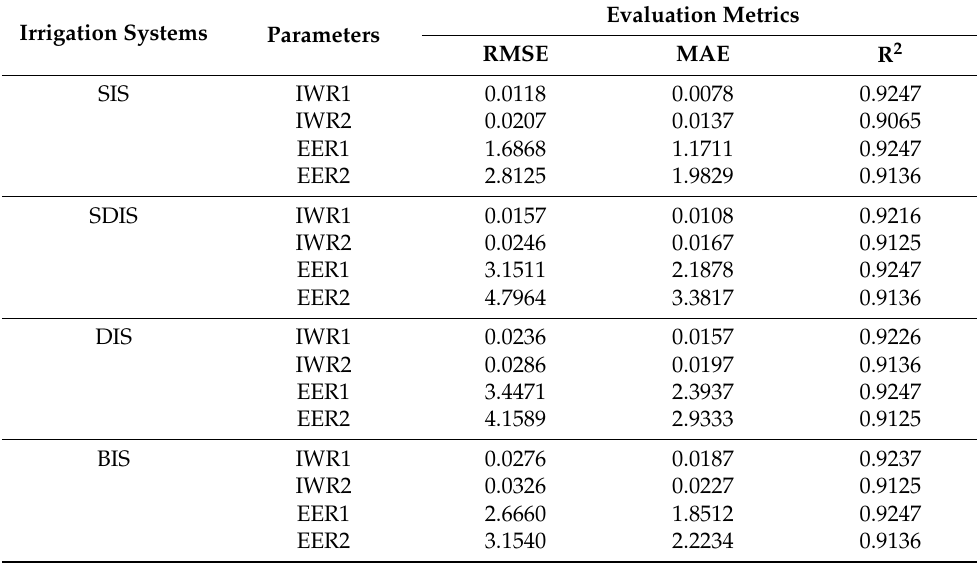
Table 7. Evaluation values of three performance metrics for LSTM models based on the validation dataset for predicting the irrigation water requirements (IWR1) and the electrical energy requirements (EER1) for optimum water use efficiency and for predicting the irrigation water requirements (IWR2) and the electrical energy requirements (EER2) for optimum date palm yield using the solar-powered micro irrigation systems. Irrigation Systems